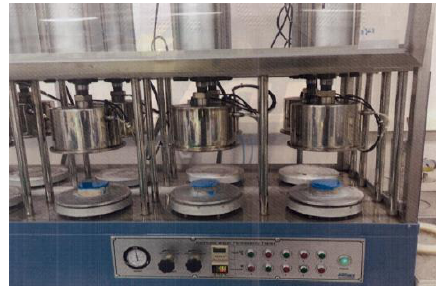
Figure 3. Impact resistance test apparatus.